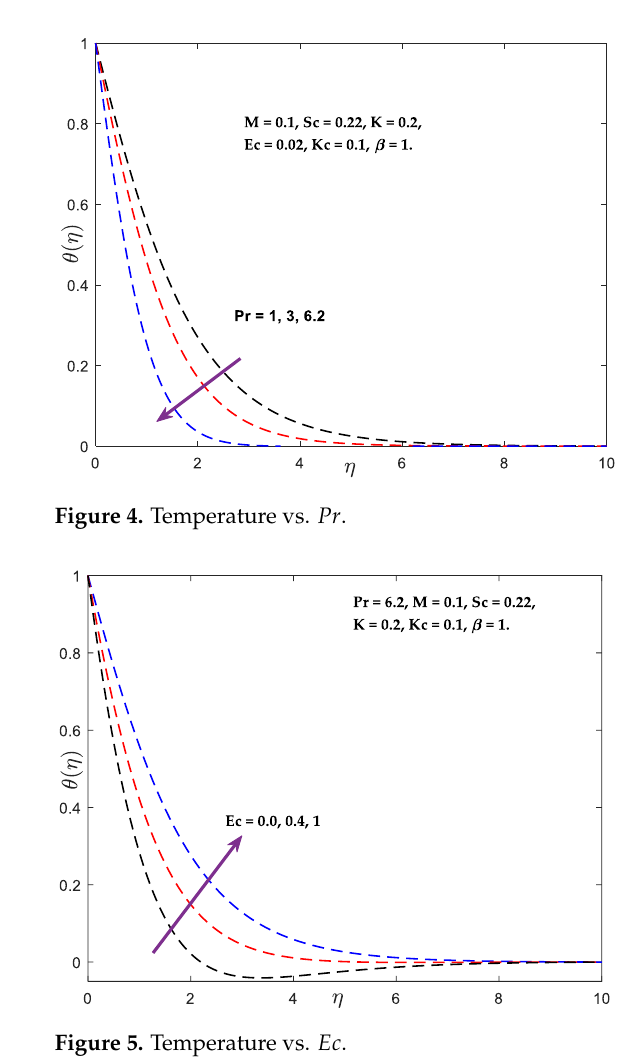
Figure 5. Temperature vs. 𝐸𝑐 .